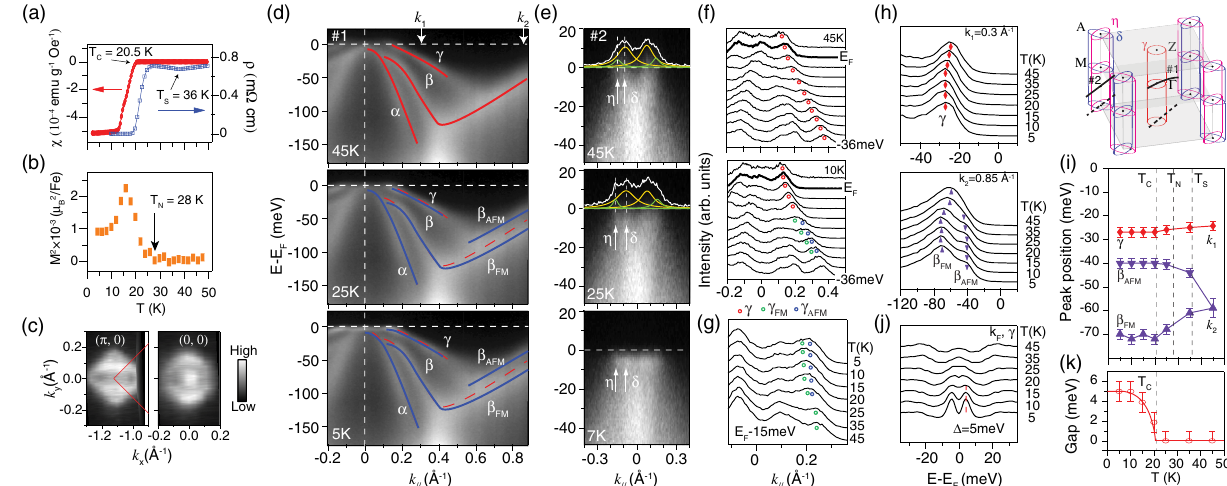
FIG. 1. (a) Magnetic susceptibility of a NaFe 0 : 9825 Co 0 : 0175 As single crystal taken at a magnetic field of 20 Oe in the zero-field cool mode, and its resistivity as a function of temperature. (b) Temperature dependence of the magnetic-order parameter at Q ¼ ð 1 ; 0 ; 1 : 5 Þ for NaFe 0 : 9825 Co 0 : 0175 As measured by neutron scattering. (c) Photoemission intensity map at the Fermi energy integrated over [ E F (cid:1) 5 meV , E F þ 5 meV ]. (d) The band structure of NaFe 0 : 9825 Co 0 : 0175 As at 45, 25, and 5 K, respectively, along cut #1 across (cid:1) , as indicated in the inset. The dashed lines in the lower panels are the band dispersion at 45 K, for comparison purposes. (e) Temperature dependence of the band structure around the zone corner along cut #2, as indicated in the inset. The MDCs (momentum-distribution curves) at E F are plotted on the 25 and 45 K data. Each MDC was fitted to four Lorentzians (overlaid yellow and green lines). (f) MDCs near the zone center at 45 and 10 K. (g) Temperature dependence of the MDC at E F (cid:1) 15 meV near the zone center. The positions of the (cid:3) band are marked in panels (f) and (g). (h) Temperature dependence of the EDCs (energy-distribution curves) at selected momenta: k 1 ¼ 0 : 3 (cid:2)A (cid:1) 1 and k 2 ¼ 0 : 85 (cid:2)A (cid:1) 1 , respectively, as marked in panel (d). Because of the broad line shape, (cid:3) AFM and (cid:3) FM are not resolved, but the shift of the overall features is obvious. (i) The temperature dependence of the peak positions in panel (h). (j) The temperature dependence of the symmetrized EDCs measured at the k F of (cid:3) . (k) The temperature dependence of the SC gap of (cid:3) . The gap size is estimated through an empirical fit, as described in detail in Ref. [36]. The inset on the top-right corner shows the Fermi surface of NaFe 0 : 9825 Co 0 : 0175 As . The two solid lines mark cut #1 and cut #2, along which the data in panels (d) and (e) are located, respectively. The two dashed lines on the bottom plane are their projections. The photoemission data in panels (c) and (e) were acquired in-house, and others were collected at